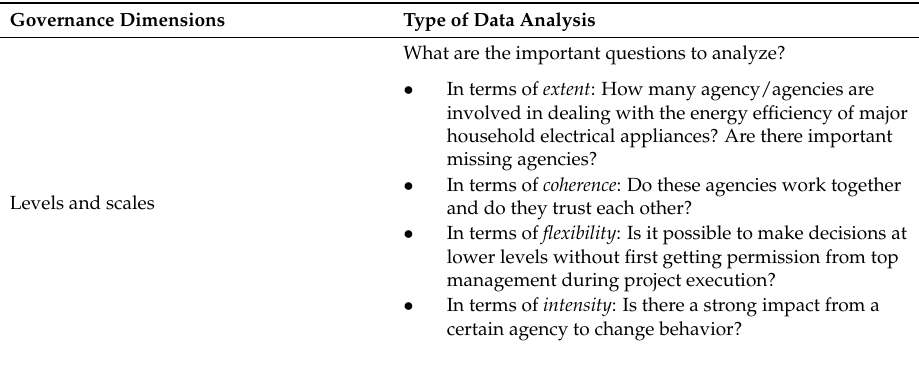
Table 3. Type of data analysis when using GAT (adapted from: Bressers, Bressers, Kuks, Larrue [37] with permission of Springer,